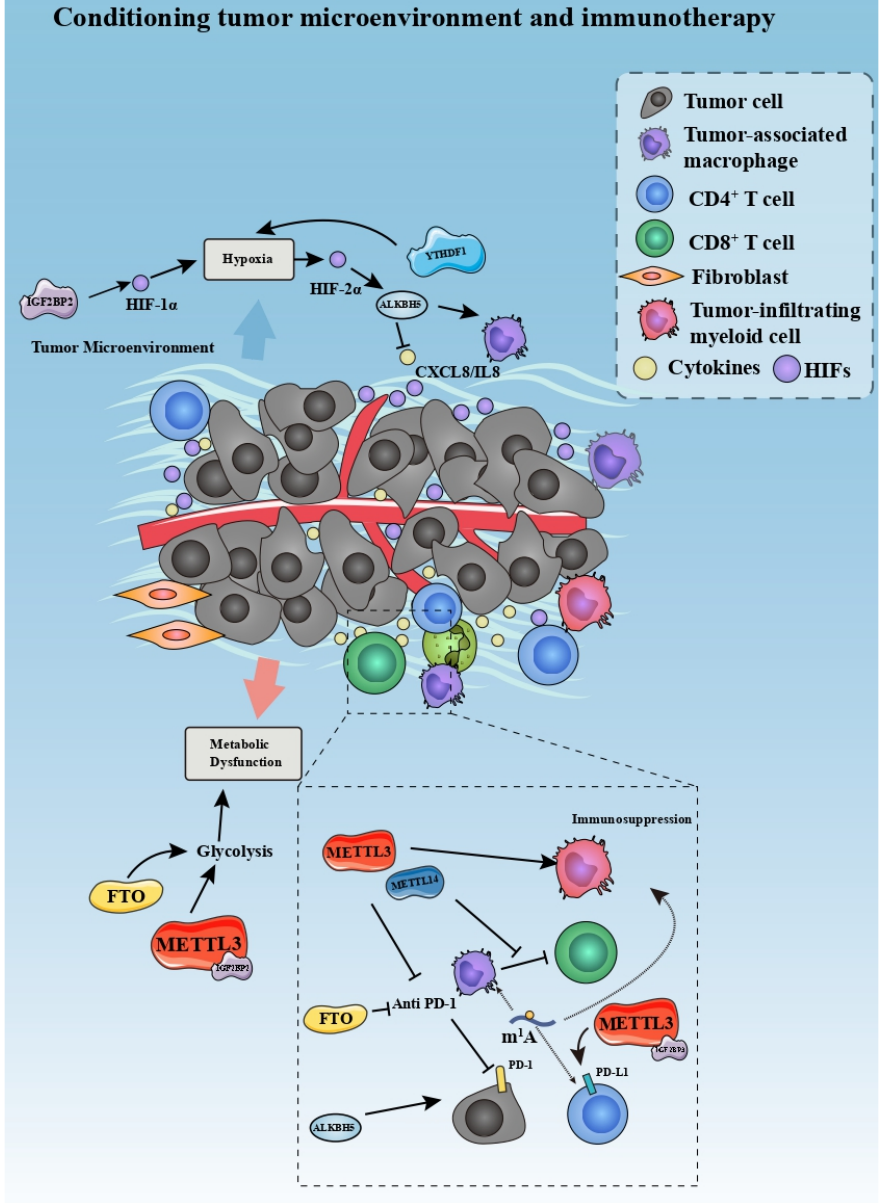
Figure 4. Methyladenosine modifications are able to condition tumor microenvironment and im- munotherapy.